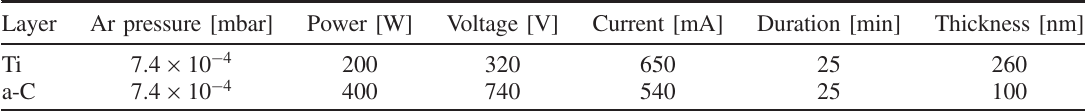
TABLE I. Coating parameters used for the production of the a-C coating and the titanium sublayer.